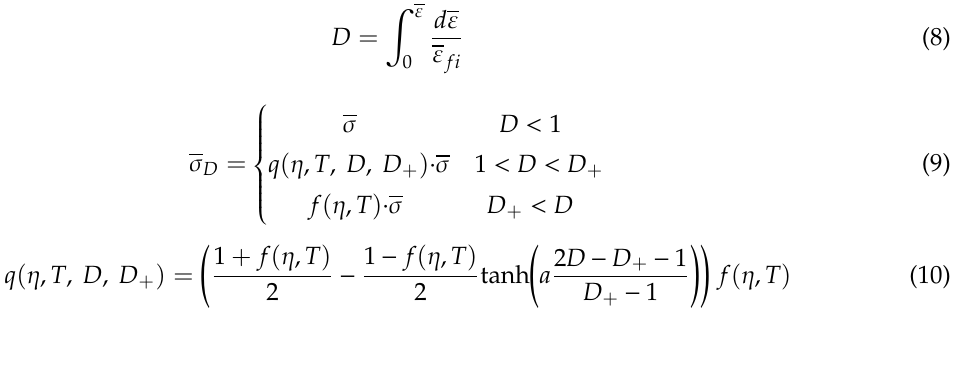
Figure 5. ( a ) Flow stress model for chip segmentation prediction with ( b ) flow stress modification factor as a function of stress triaxiality and temperature from Childs et al. using ( c ) the fracture initiation strain as a function of stress triaxiality.